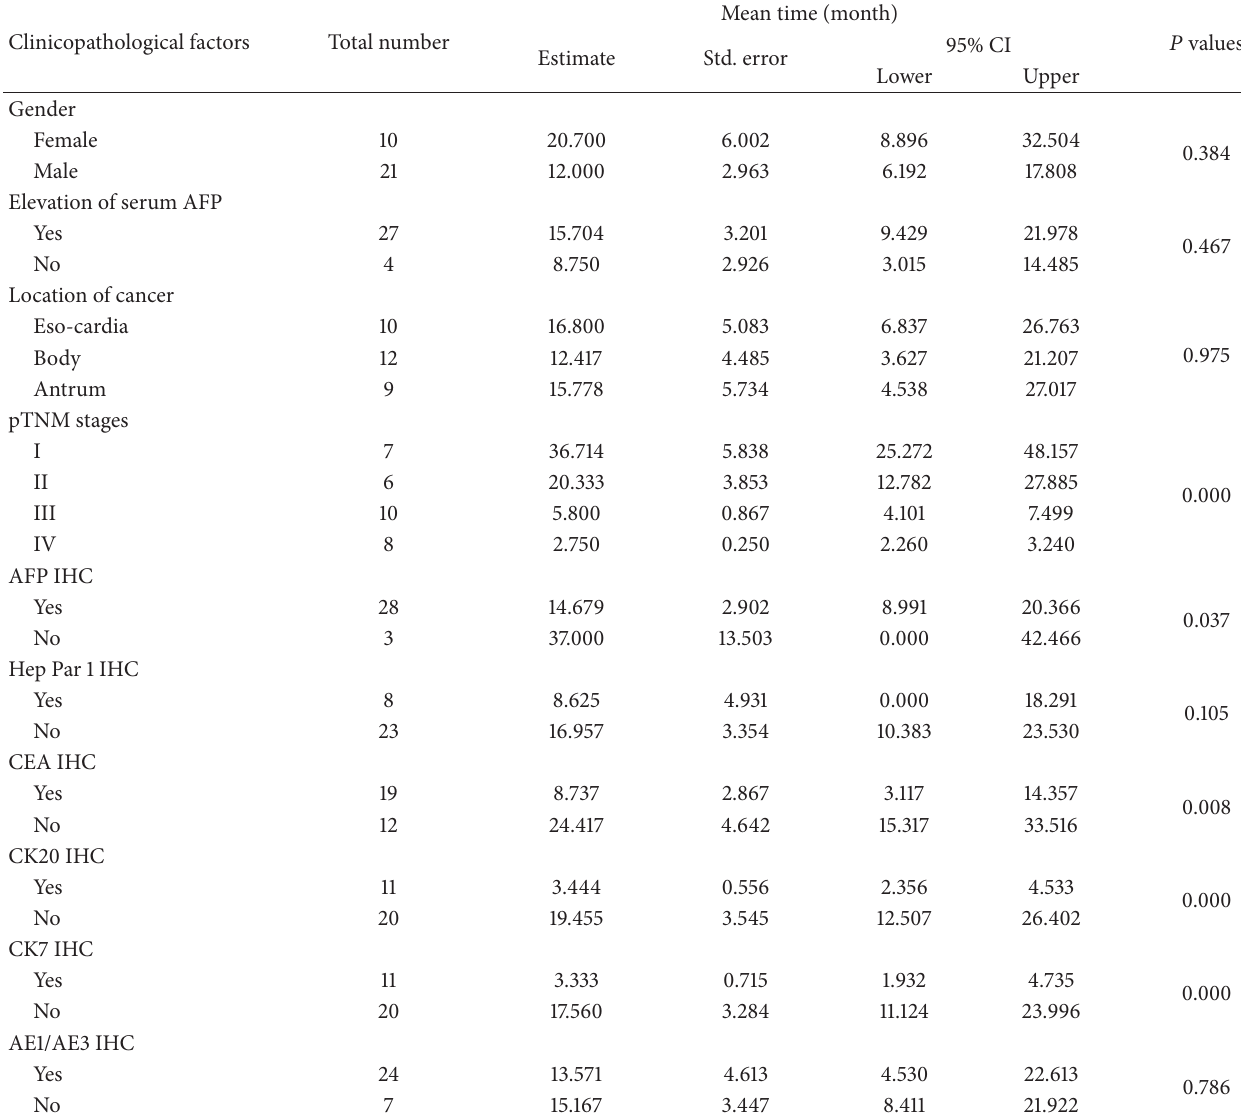
Table 1: Prognostic factors related to prognosis by the Kaplan-Meier